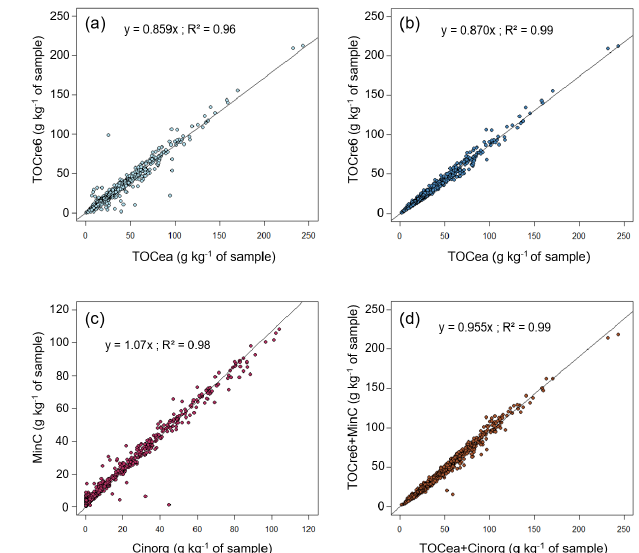
Figure 1. Carbon yields of Rock-Eval ® thermal analysis. Panel (a) presents the organic carbon yield of TOCre6 as a func- tion of TOCea for all analysed RMQS topsoil (0–30cm) samples. Panel (b) shows the organic carbon yield of TOCre6 as a func- tion of TOCea for the RMQS topsoil samples limited to those with Rock-Eval ® organic carbon yields ranging from 0.7 to 1.3. Panel (c) presents the inorganic carbon yield of MinC as a func- tion of Cinorg for the RMQS topsoil samples limited to those with Rock-Eval ® organic carbon yields ranging from 0.7 to 1.3. Panel (d) shows the total carbon yield of TOCre6 + MinC as a func- tion of TOCea + Cinorg for the RMQS topsoil samples limited to those with Rock-Eval ® organic carbon yields ranging from 0.7 to